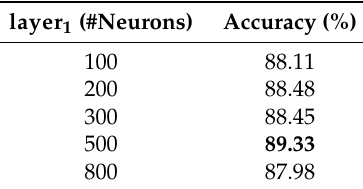
Table 5. Average classification results for an RBM with a hidden layer using the AAhydro set.